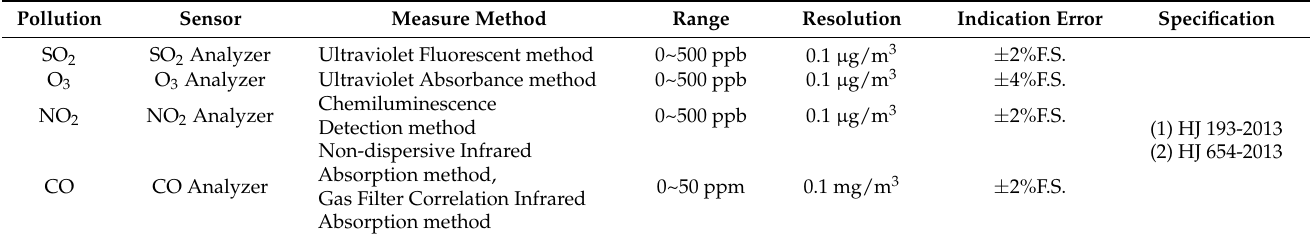
Table A5. Parameters and Specifications of the sensors to measure SO 2 , NO 2 , O 3 and